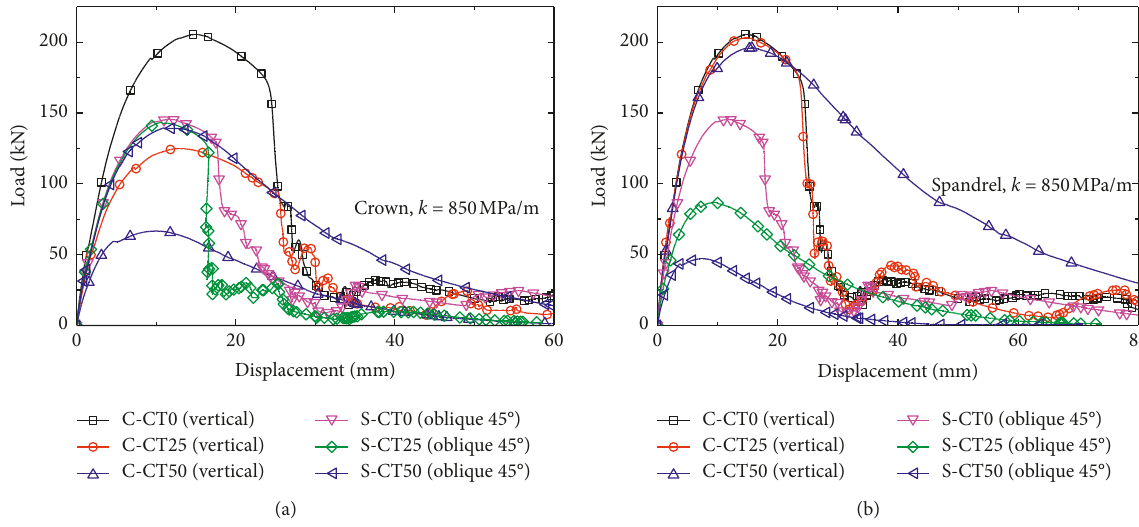
Figure 12: Load-displacement curve of thinned lining. (a) Thinning of lining at vault crown. (b) Thinning of lining at vault